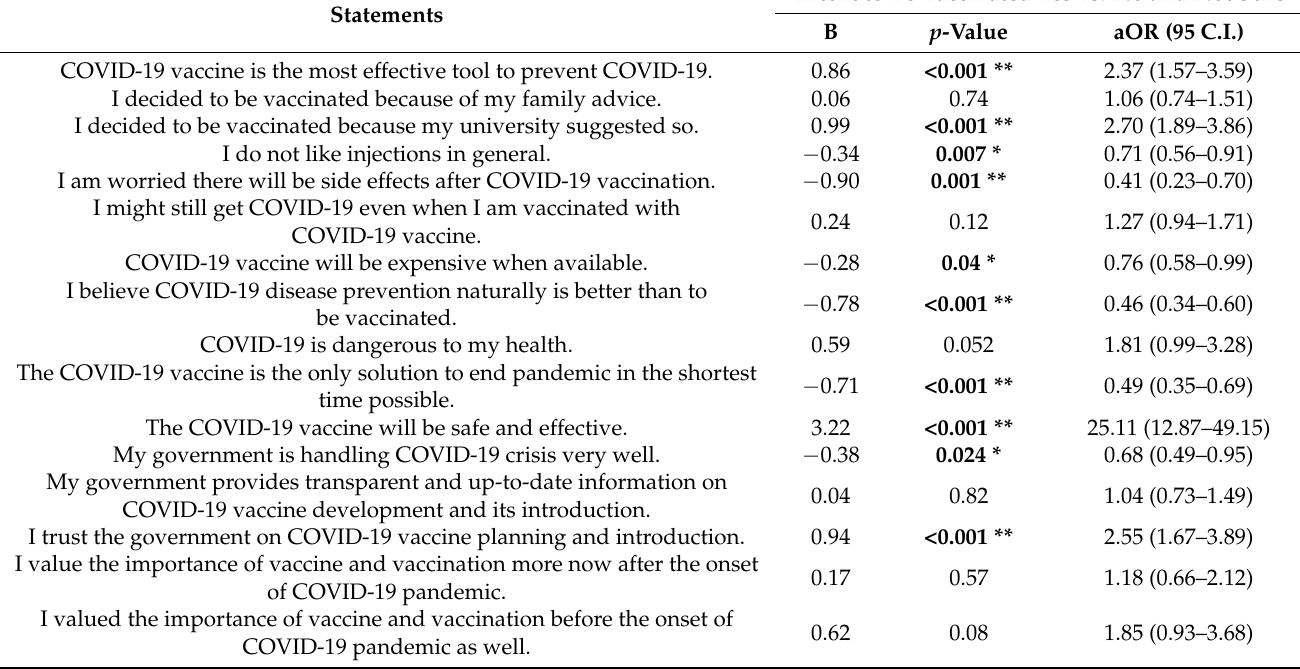
Table 5. Multivariate logistic regression analysis of willingness to receive COVID-19 vaccine with positive responses for Likert scale